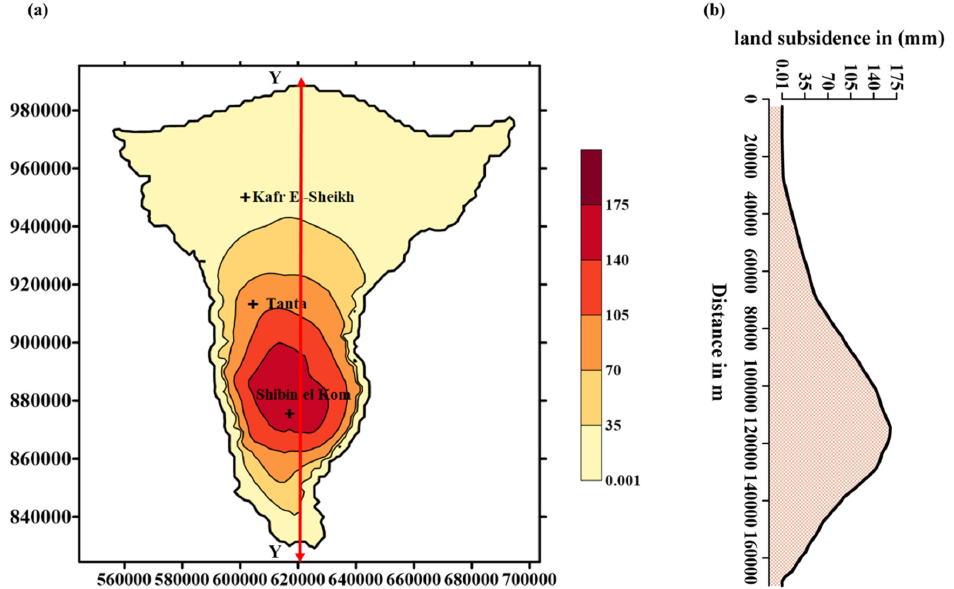
Table 4. Land subsidence model calibration scenario.